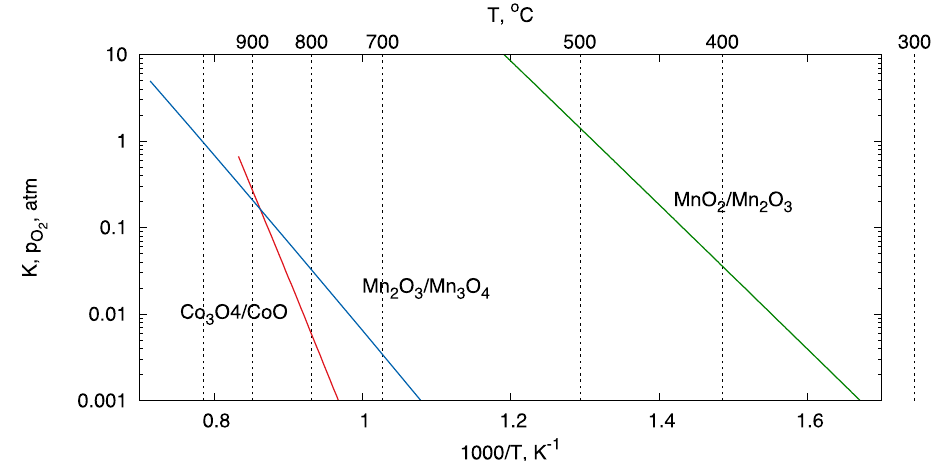
Figure 7. Thermodynamic equilibrium conditions for the cobalt oxide and manganese oxide systems.